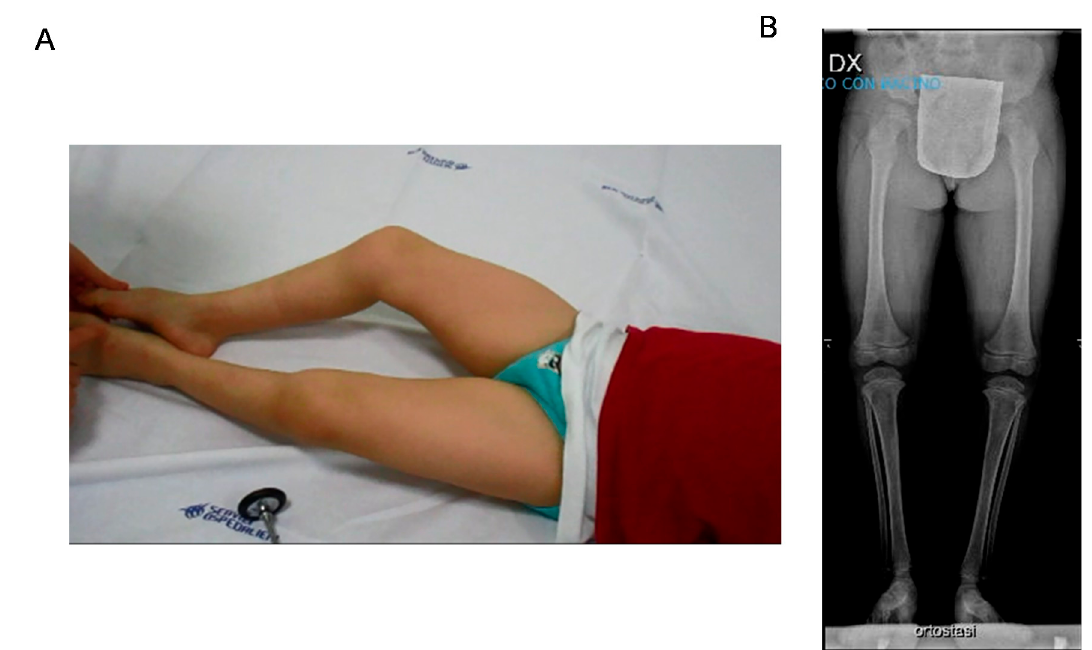
Figure 1. ( A ) Patient at rest aged 9 years. Lower limb stiffness with bent knees and hip posture is evident. Increased muscle bulk of tight muscles is also pictured. ( B ) X-rays of lower limbs in standing position showed shallow hip acetabulum, flattened femoral epiphyses, and slender diaphysis of the tibia.